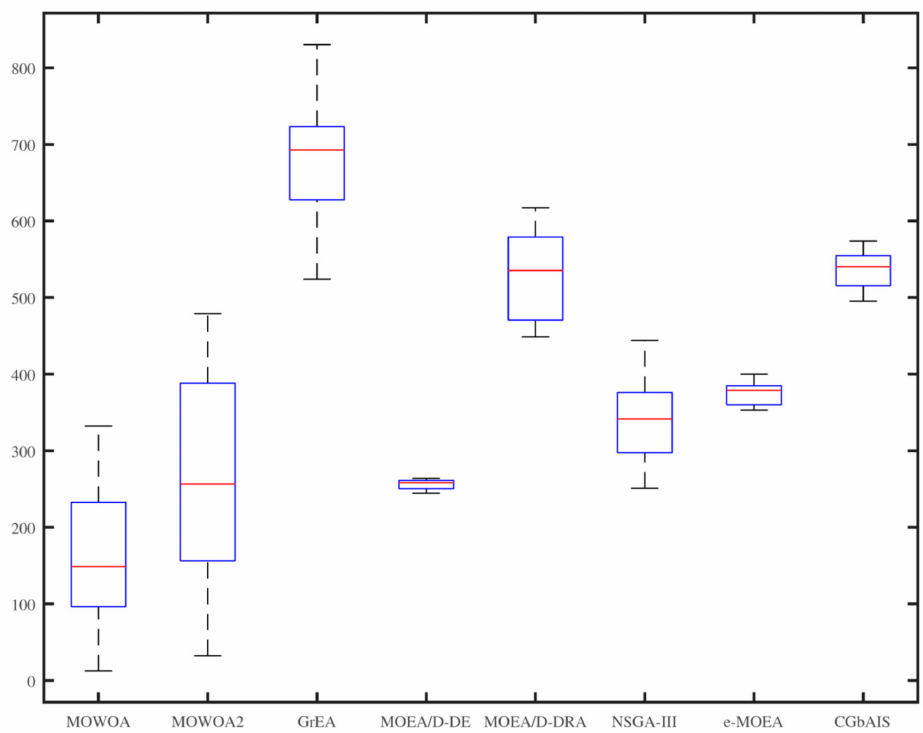
Figure 7. Energy consumption of the different algorithms when the user number is 45.